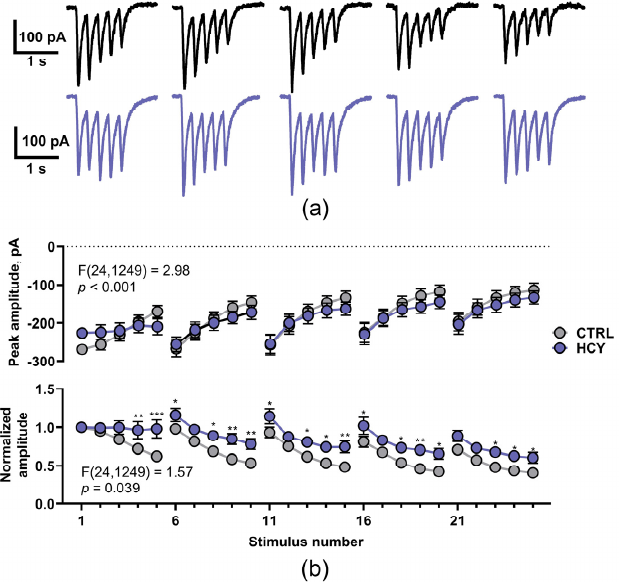
Figure 5. The altered properties of NMDAR-mediated currents evoked by TBS in HCY rats. ( a ) The representative voltage-clamp recordings of NMDAR-mediated currents, induced by TBS in CA1 neurons in control (black) and HCY rats (orange). ( b ) Upper trace: the average amplitudes of the individual peaks of current within the responses ( n = 25 both for control and HCY groups); Lower trace: the same dataset, normalized to the amplitude of the first response. In both cases, the mixed-model ANOVA revealed a significant interaction between the factors (HCY×stimulus number; the p -values are reported on the figure). Asterisks indicate the significant difference between control and HCY rats (the values, which correspond to the same stimulus number, were compared using the Dunnett’s post hoc test).